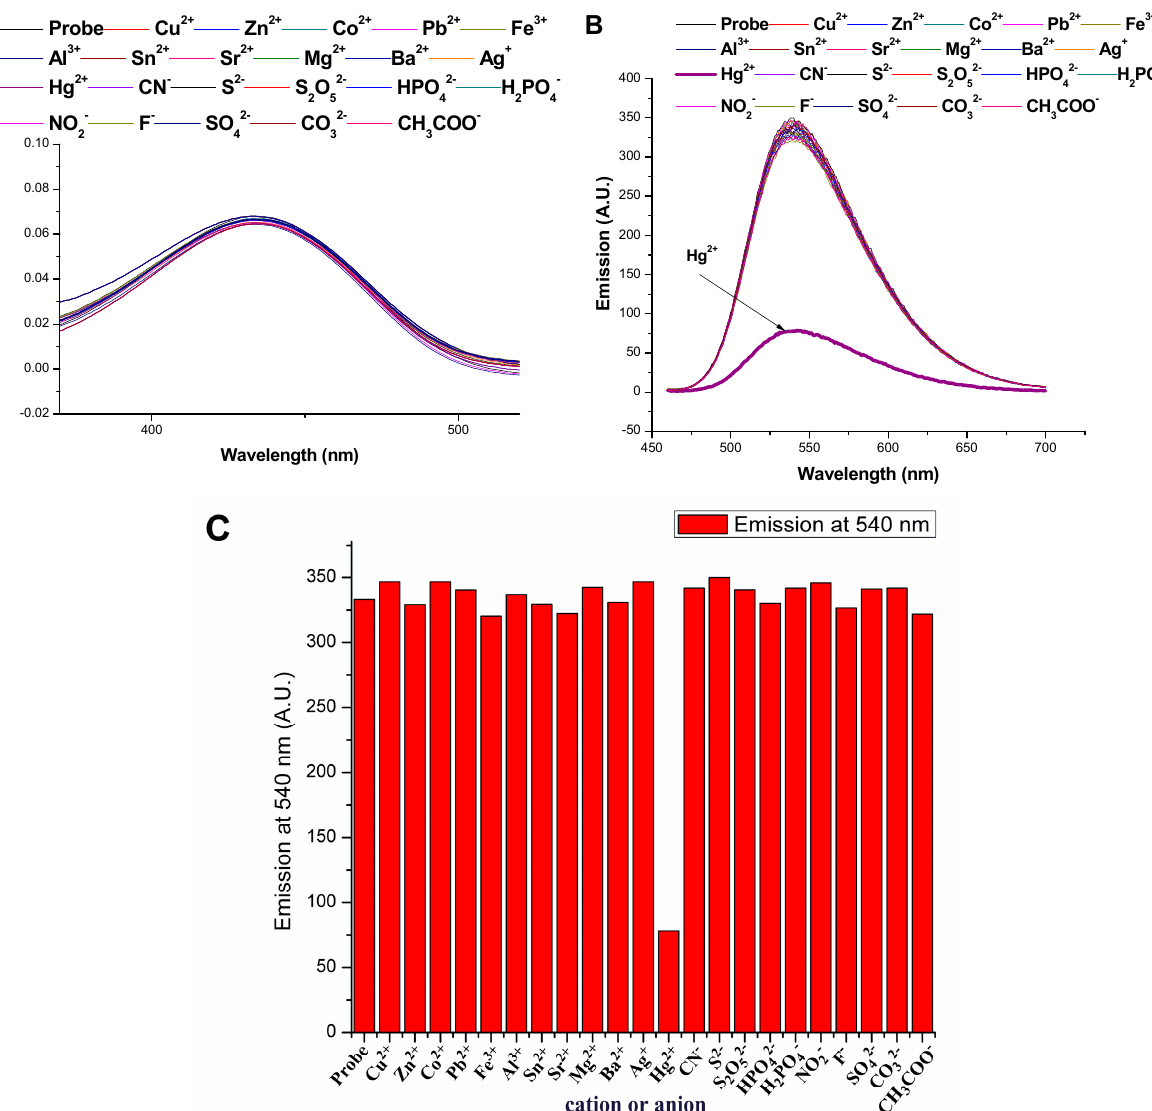
Figure 5, among all the used cations, only Hg 2+ affected the emission of the probe where it quenched its emission (EQ = 77%). This emission quenching (EQ) has been ascribed to the coordination of Hg 2+ with NH 2 groups switching the PET to 1,8-naphthalimide from triazine nitrogens. On the other hand, none of the cations under study significantly affected the absorption spectrum, which confirms that NH- group, attached directly to 1,8-naphthalimide, does not participate in the coordination with Hg 2+ .